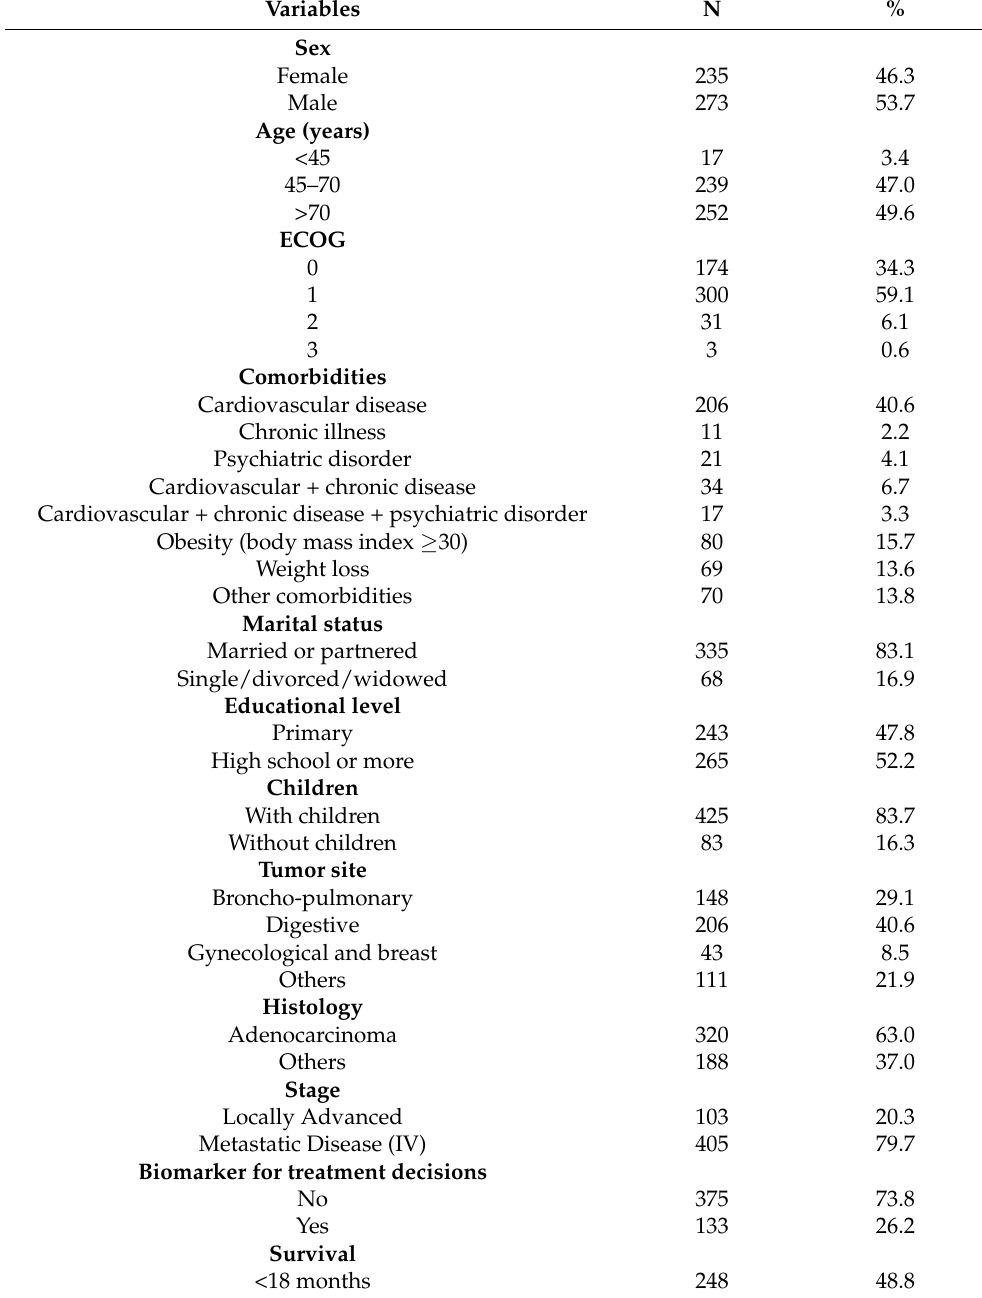
Table 1. Cancer types, stages, and medical comorbidities of patients ( n = 508).